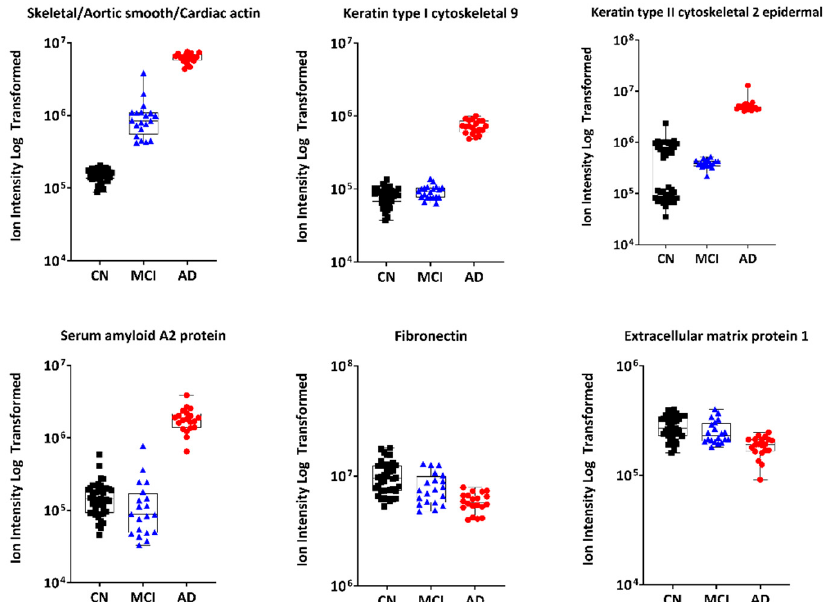
Figure 2. The top 6 protein biomarkers that separated the MCI group from the CN group in Table 2. The CN group is shown in black while the MCI and AD groups are shown in blue and red, respectively. Abbreviations: AD, Alzheimer’s disease; CN, cognitively normal; EFEMP1, epidermal growth factor containing fibulin like extracellular matrix protein 1; MCI, mild cognitive impairment.